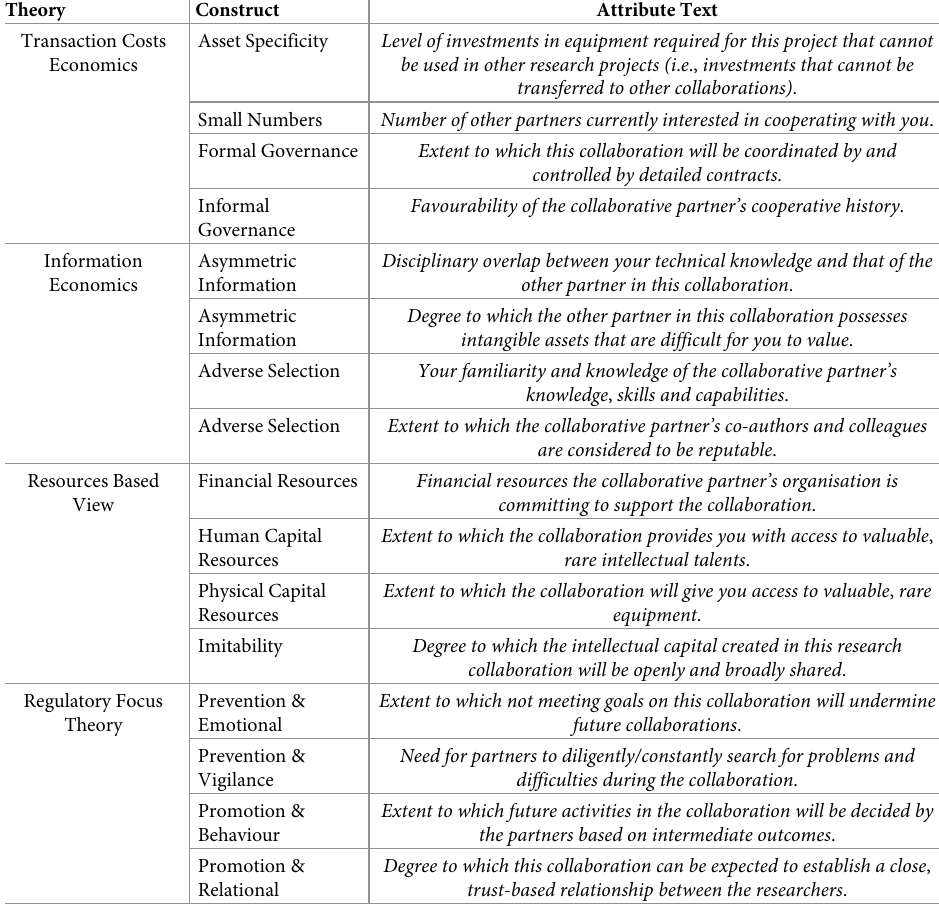
Table 1. Theoretical constructs. Overview of the theoretical constructs behind every attribute of the PC